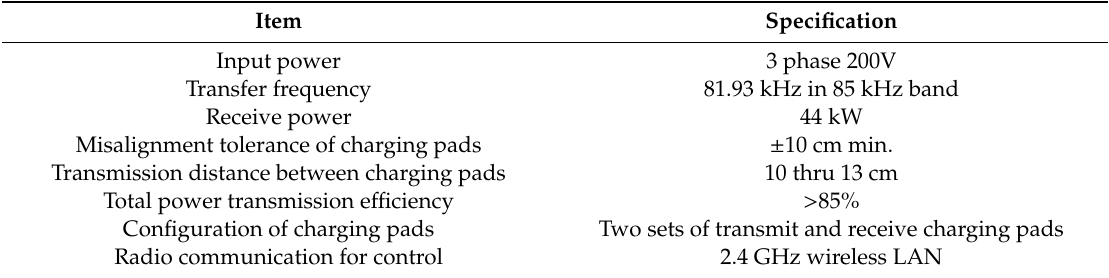
Table 1. Specifications of 85 kHz band 44 kW wireless rapid charging system.